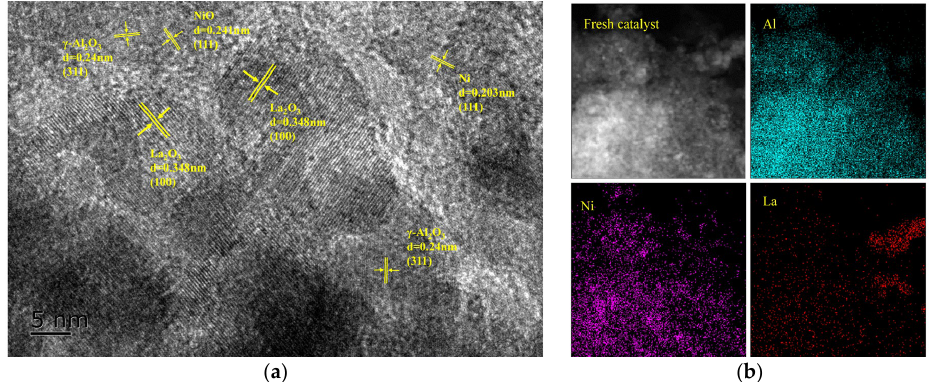
Figure 1. ( a ) HRTEM image and ( b ) EDX elemental maps for the fresh La − Ni/ γ− Al 2 O 3